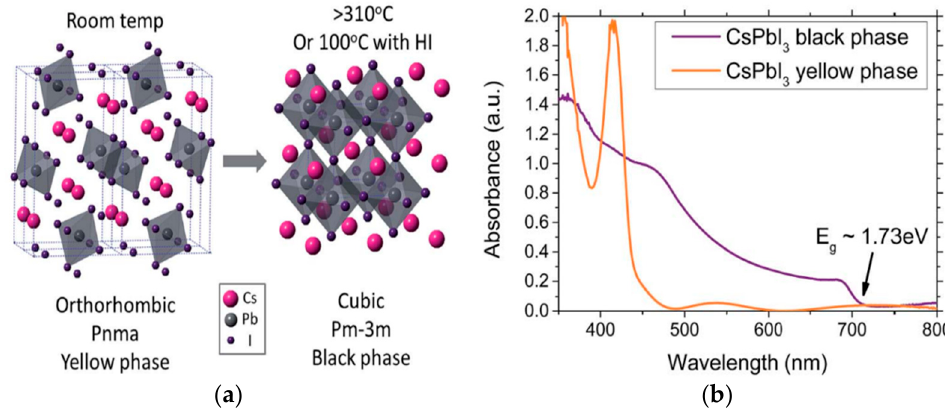
Figure 3. ( a ) Crystal structure of CsPbI 3 ; ( b ) Absorbance spectra of CsPbI 3 [27].